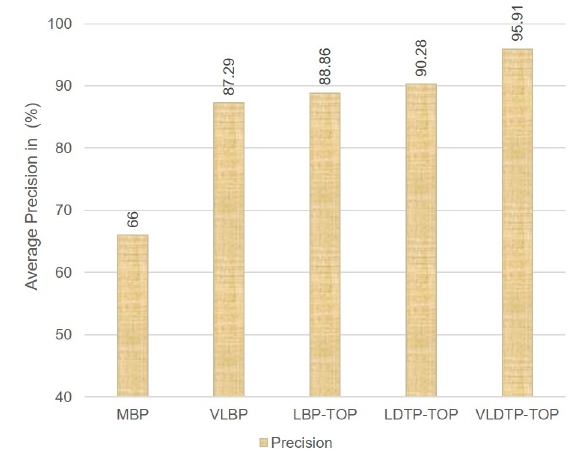
Figure 16. Precision of each category for MBP, LBP–TOP, and VLDTP–TOP descriptors on the STAD dataset.